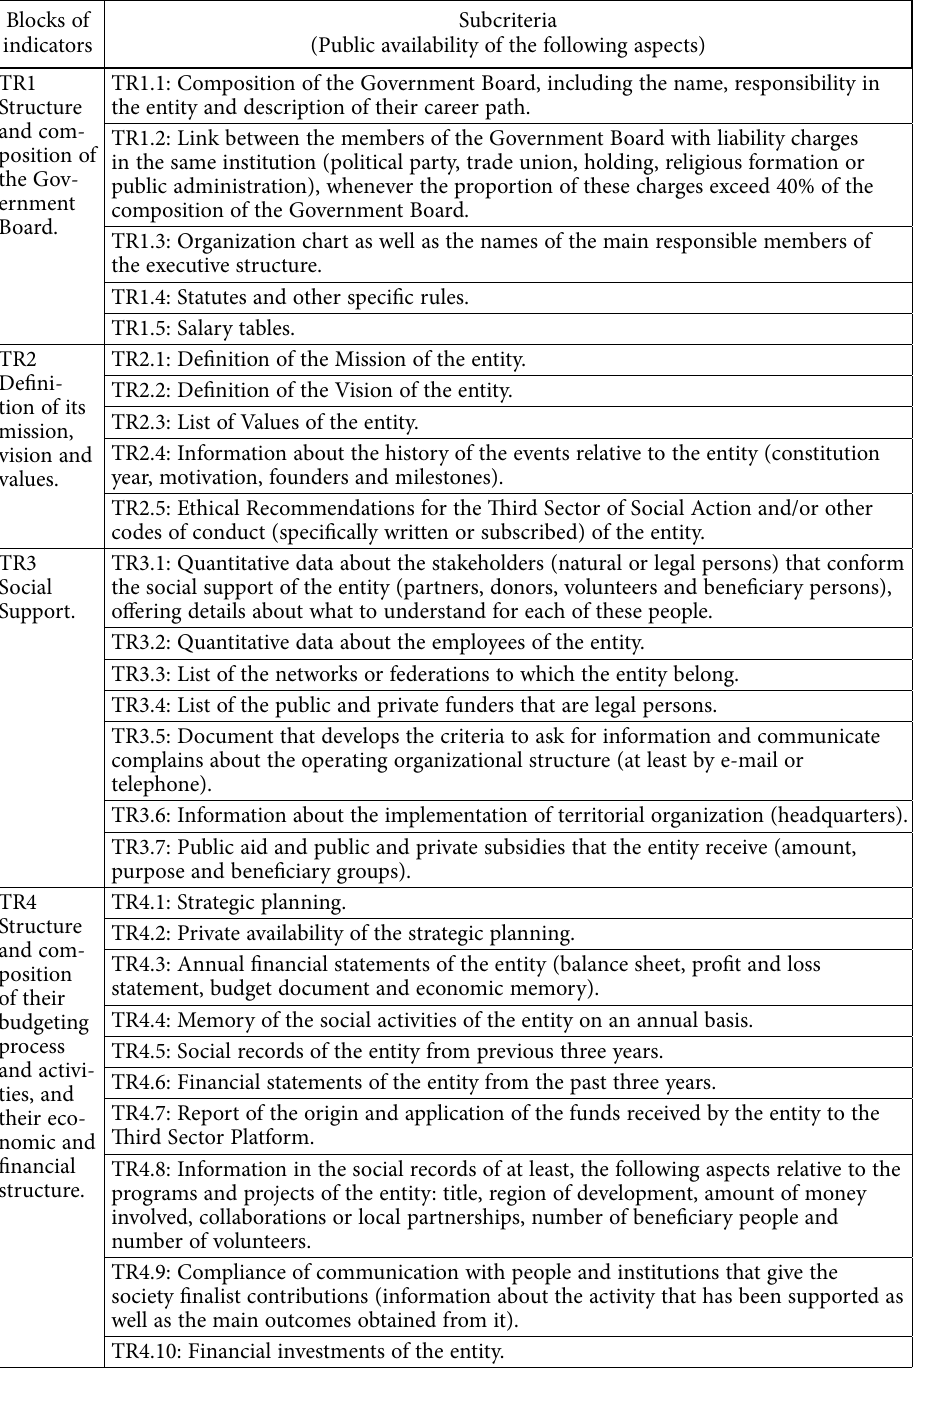
Subcriteria (Public availability of the following